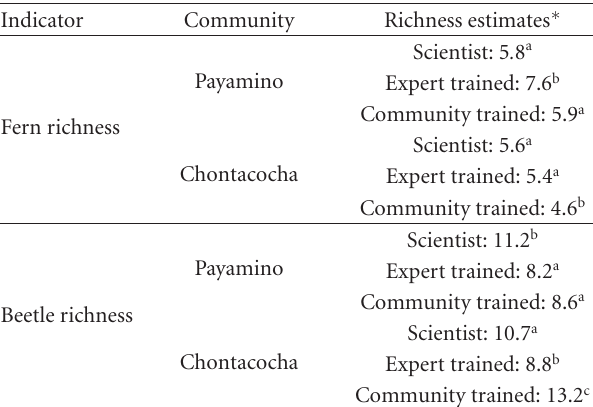
Table 1: Matched-pairs analysis results showing di ff erences in species richness estimates between scientist, expert-trained, and community-trained